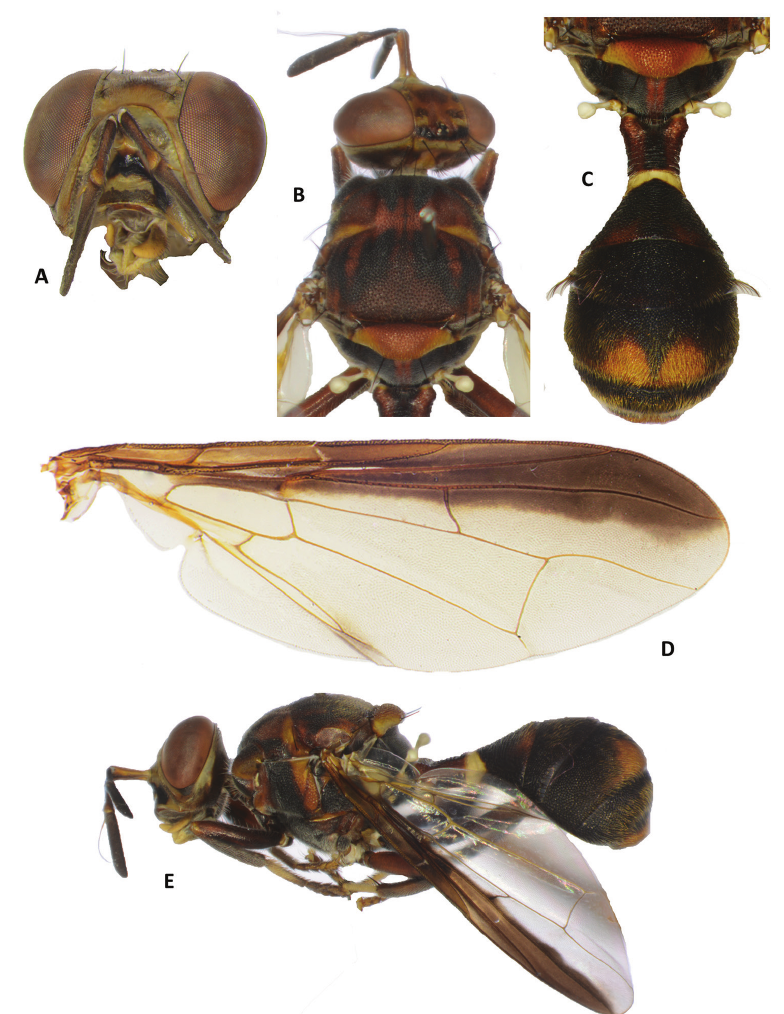
Figure 2. Dacus ( Mellesis ) vijaysegerani (Drew and Hancock). A head B head and scutum C abdomen D wing E lateral